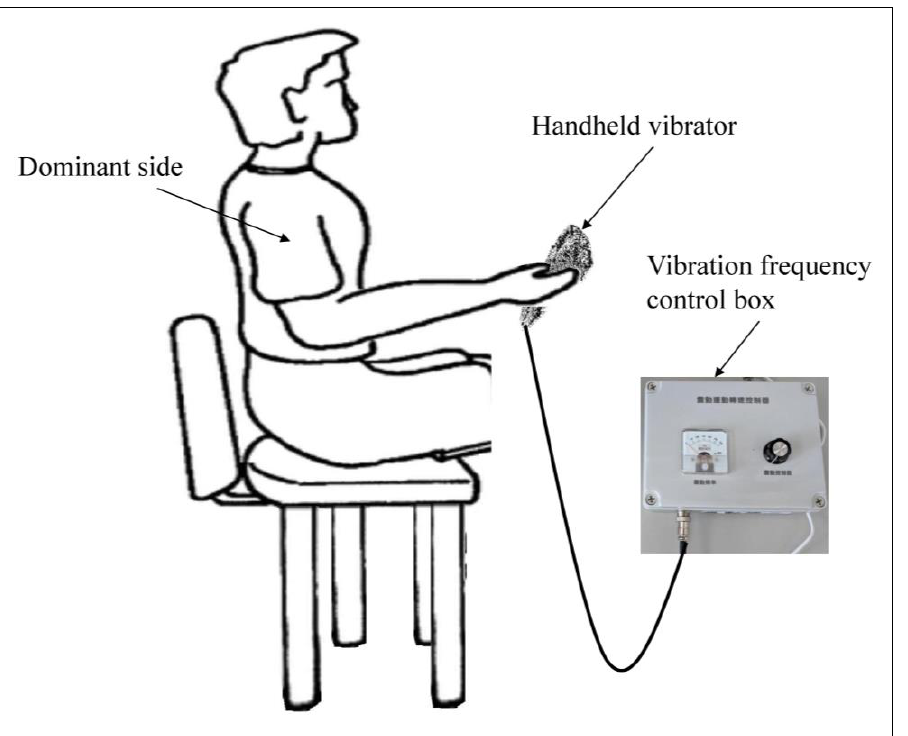
Figure 3. Experimental setting for the vibration.